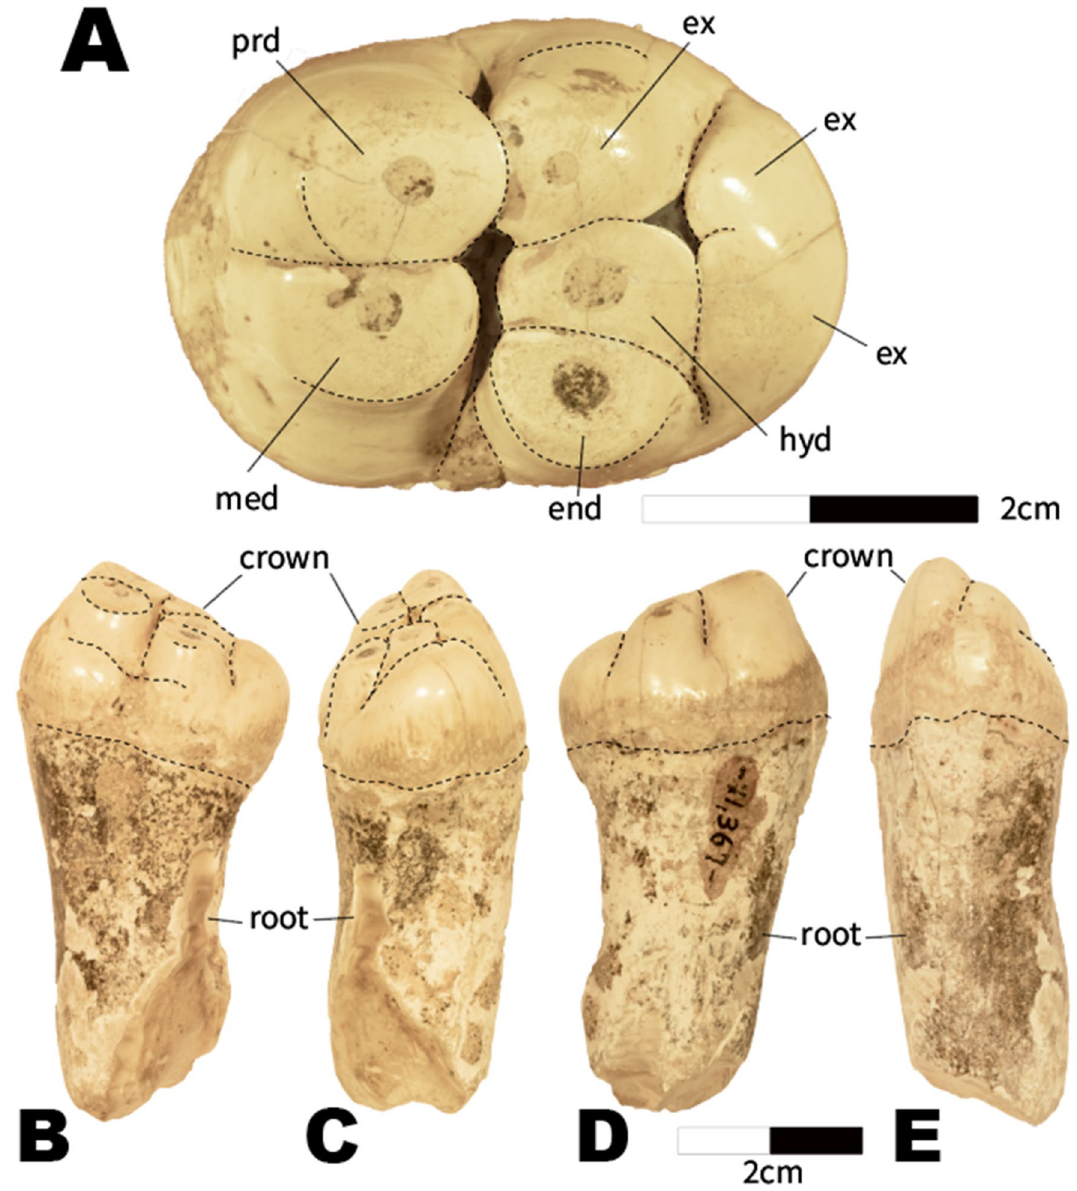
Figure 2. USNM PAL V 11367. ( A ) occlusal surface; ( B ) buccal view; ( C ) posterior view; ( D ) lingual side; ( E ) anterior view. All scale bars are 2 cm. prd: protoconid; med: metaconid; hyd: hypoconulid; end: